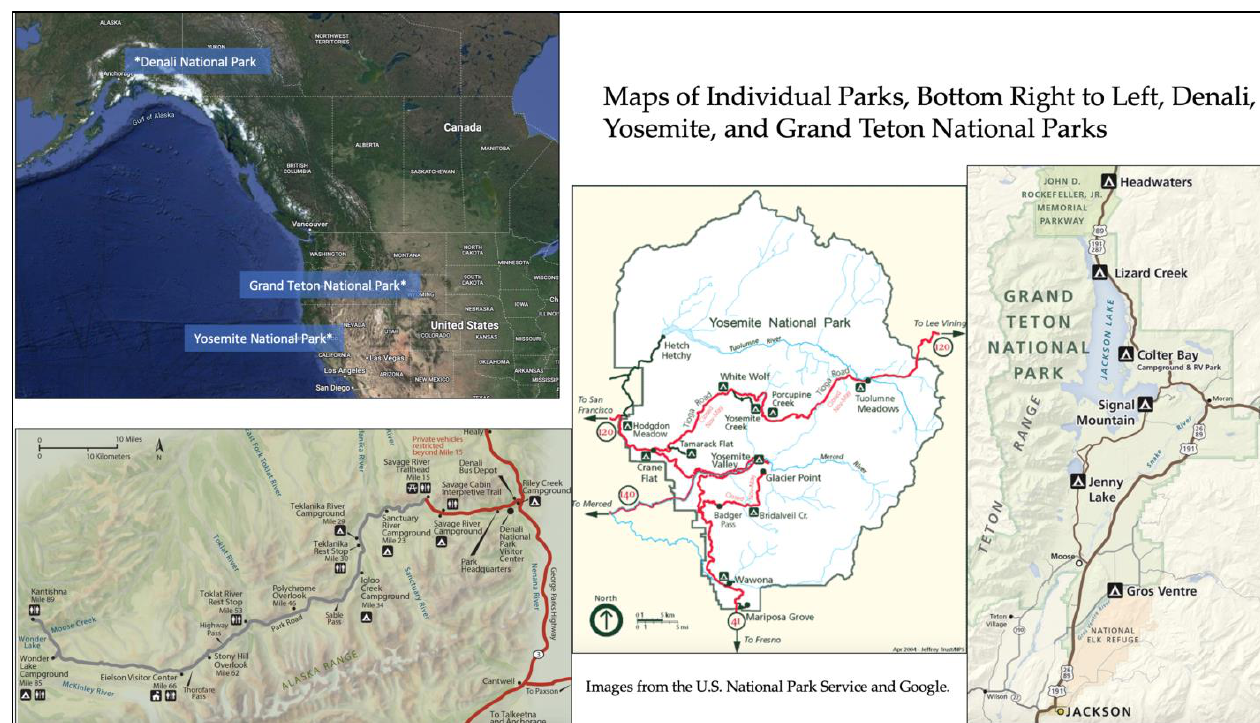
Figure 1. Study Site Locations.